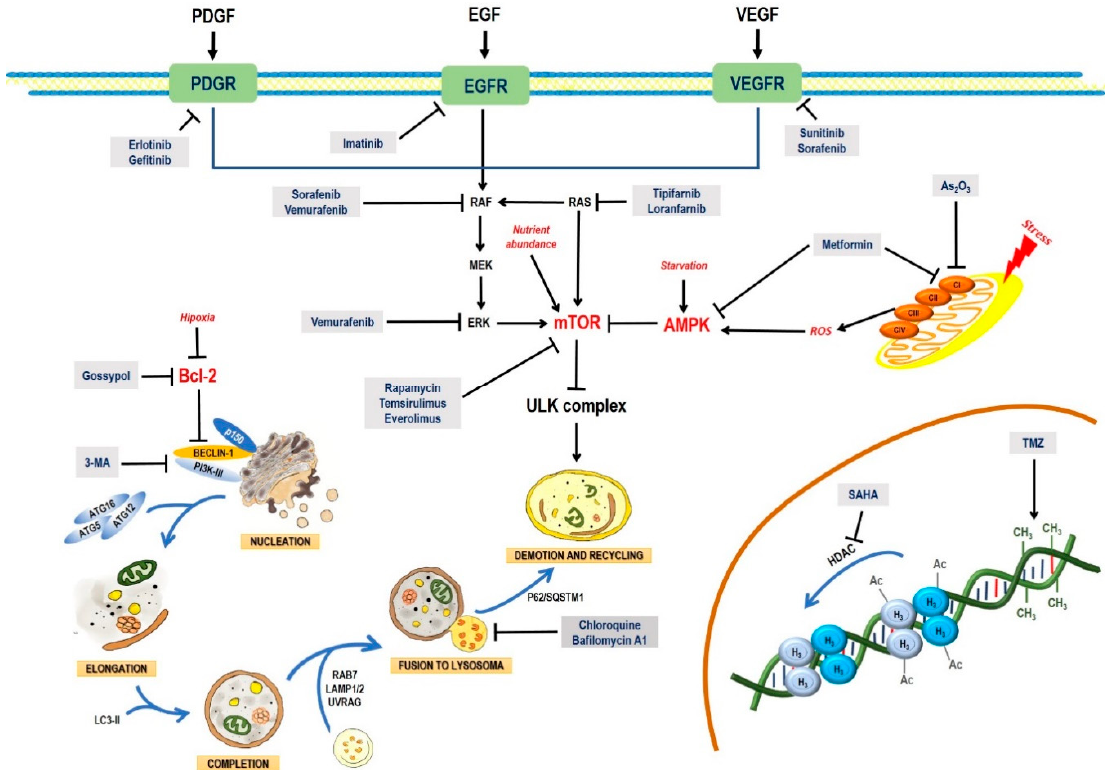
Figure 3. Molecular targets of antineoplastic agents in autophagy signaling pathways. Erlotinib and gefitinib (EGFR inhibitors), imatinib (PDGFR inhibitor), sunitinib and sorafenib (VEGF inhibitors), Tipifarnib and lonafarnib (farnesyl transferase inhibitors), sorafenib and vemurafenib (RAF and ERK inhibitor). Metformin inhibits AMPK and the Complex I (CI) of the mitochondrial electron transport chain; CI is also inhibited by AS 2 O 3 , rapamycin, temsirolimus, and everolimus (mTOR inhibitors), gossypol (Bcl-2 inhibitor), 3-MA (PI3K-III), chloroquine, and bafilomycin A1 (autophagy inhibitors), SAHA (HDAC inhibitor), and TMZ (alkylating agent). Black truncated arrows ( ⊥ ) indicate inhibition.